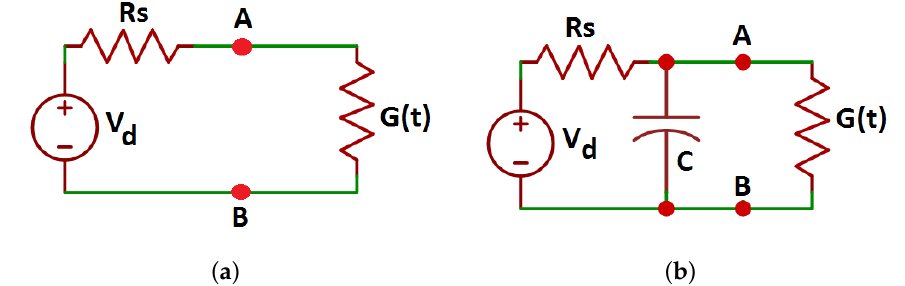
Figure 5. Configuration. ( a ) Battery model. ( b ) EMI